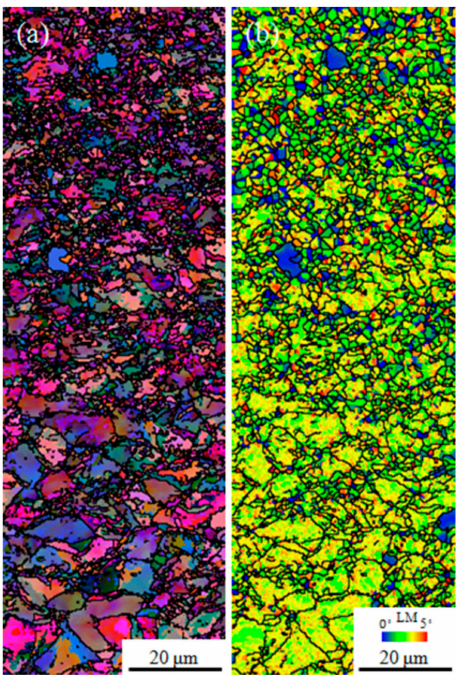
Figure 8. EBSD maps of the USRP-treated sample after hot compression test at the true strain rate of 0.001 s − 1 and temperature of 700 ◦ C: ( a ) all Euler angles map, ( b ) LM